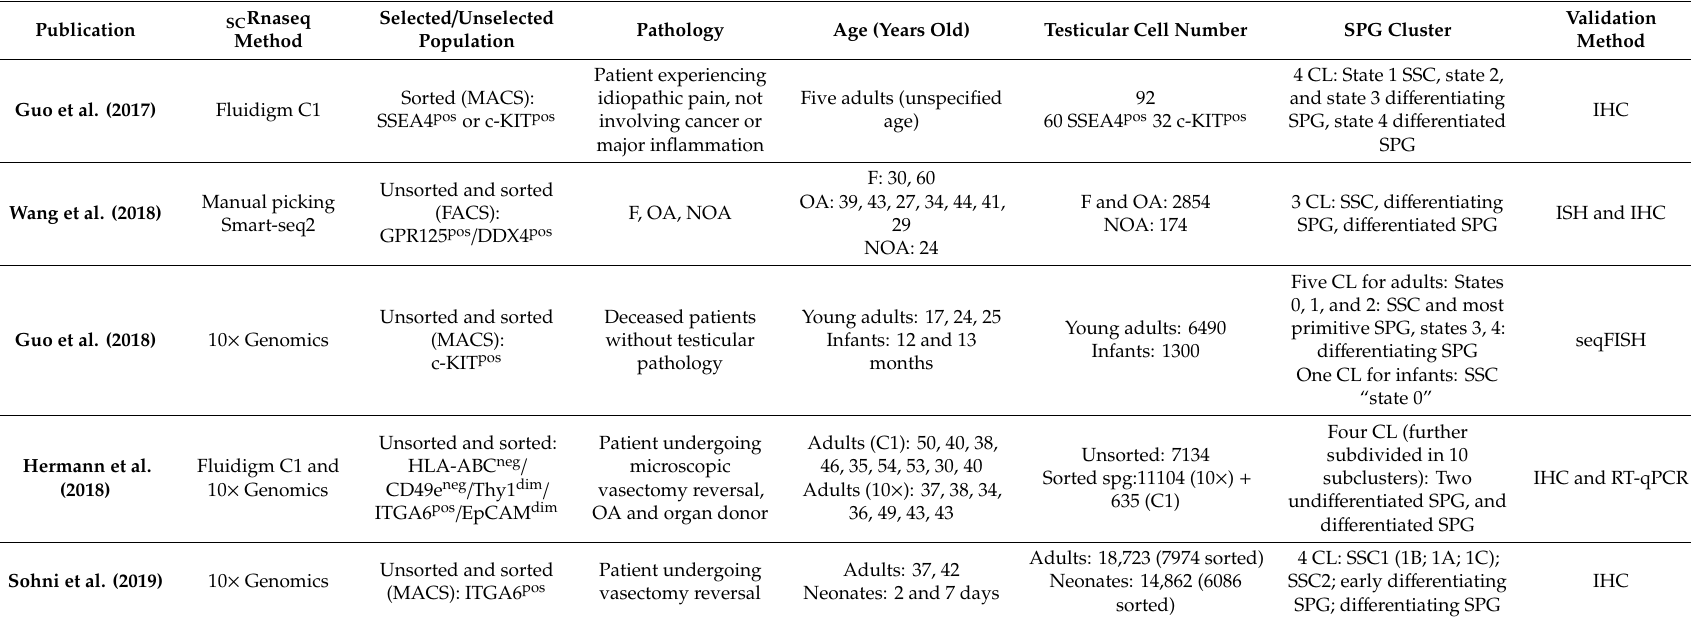
Table 1. scRNAseq datasets on human spermatogonia